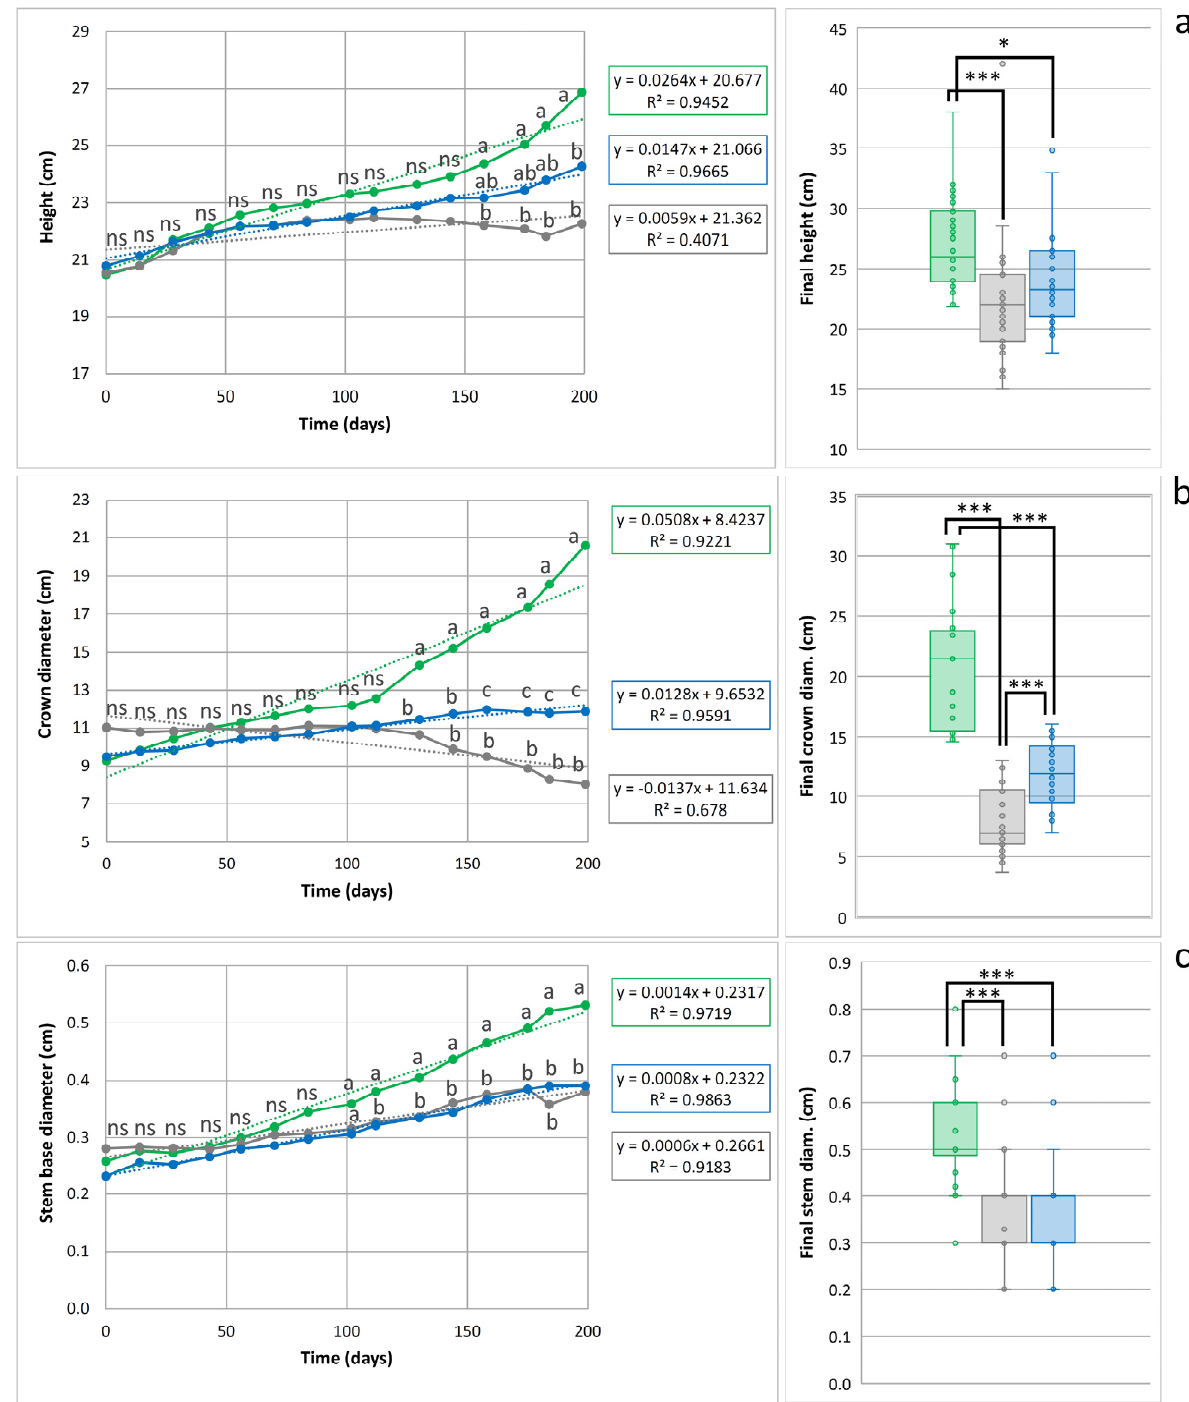
Figure 2. Growth of Helichrysum microphyllum subsp. tyrrhenicum in the greenhouse test. ( a ) Plant height, ( b ) crown diameter, ( c ) stem base diameter. Left panel. Kinetics and linear least squares best-fit line of the growth parameters. Each value is the mean of the measurements on the 30 pots for each experimental condition. Significant differences between the tested conditions in the pairwise comparisons ( p < 0.05) are represented by different lowercase letter labels. ns: p > 0.05. Right panel. Box plot of the growth parameters measured at the end of the test. Bars are drawn from each box to the higher and lower data within 1.5 times the interquartile range. * p < 0.05, *** p < 0.001. Green: commercial garden substrate (GARD), Gray: contaminated substrate without amendment (UNAM), Blue: contaminated substrate amended with wood chips